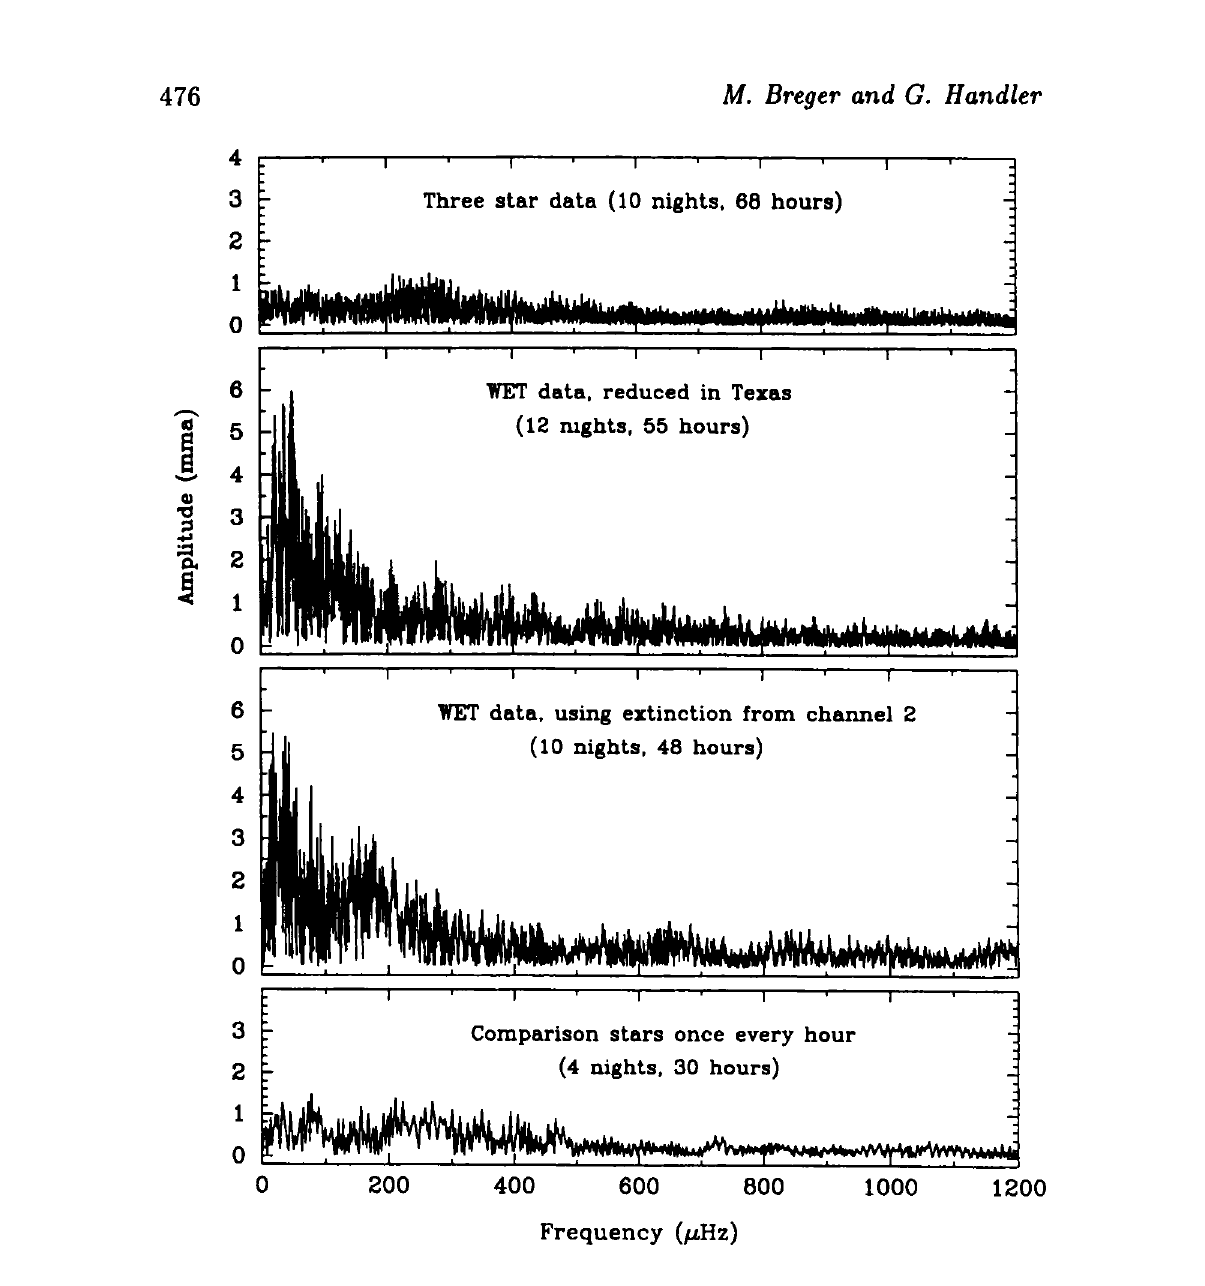
Fig. 2. The comparison of the noise spectrum of three different ob- serving techniques. Measurements of the Delta Scuti variable FG Vir are used after a nine-frequency fit (determined from all available data) was prewhitened. The top panel shows the three-star technique, the middle panels show the continuous WET technique, while the Hour technique is shown in the bottom